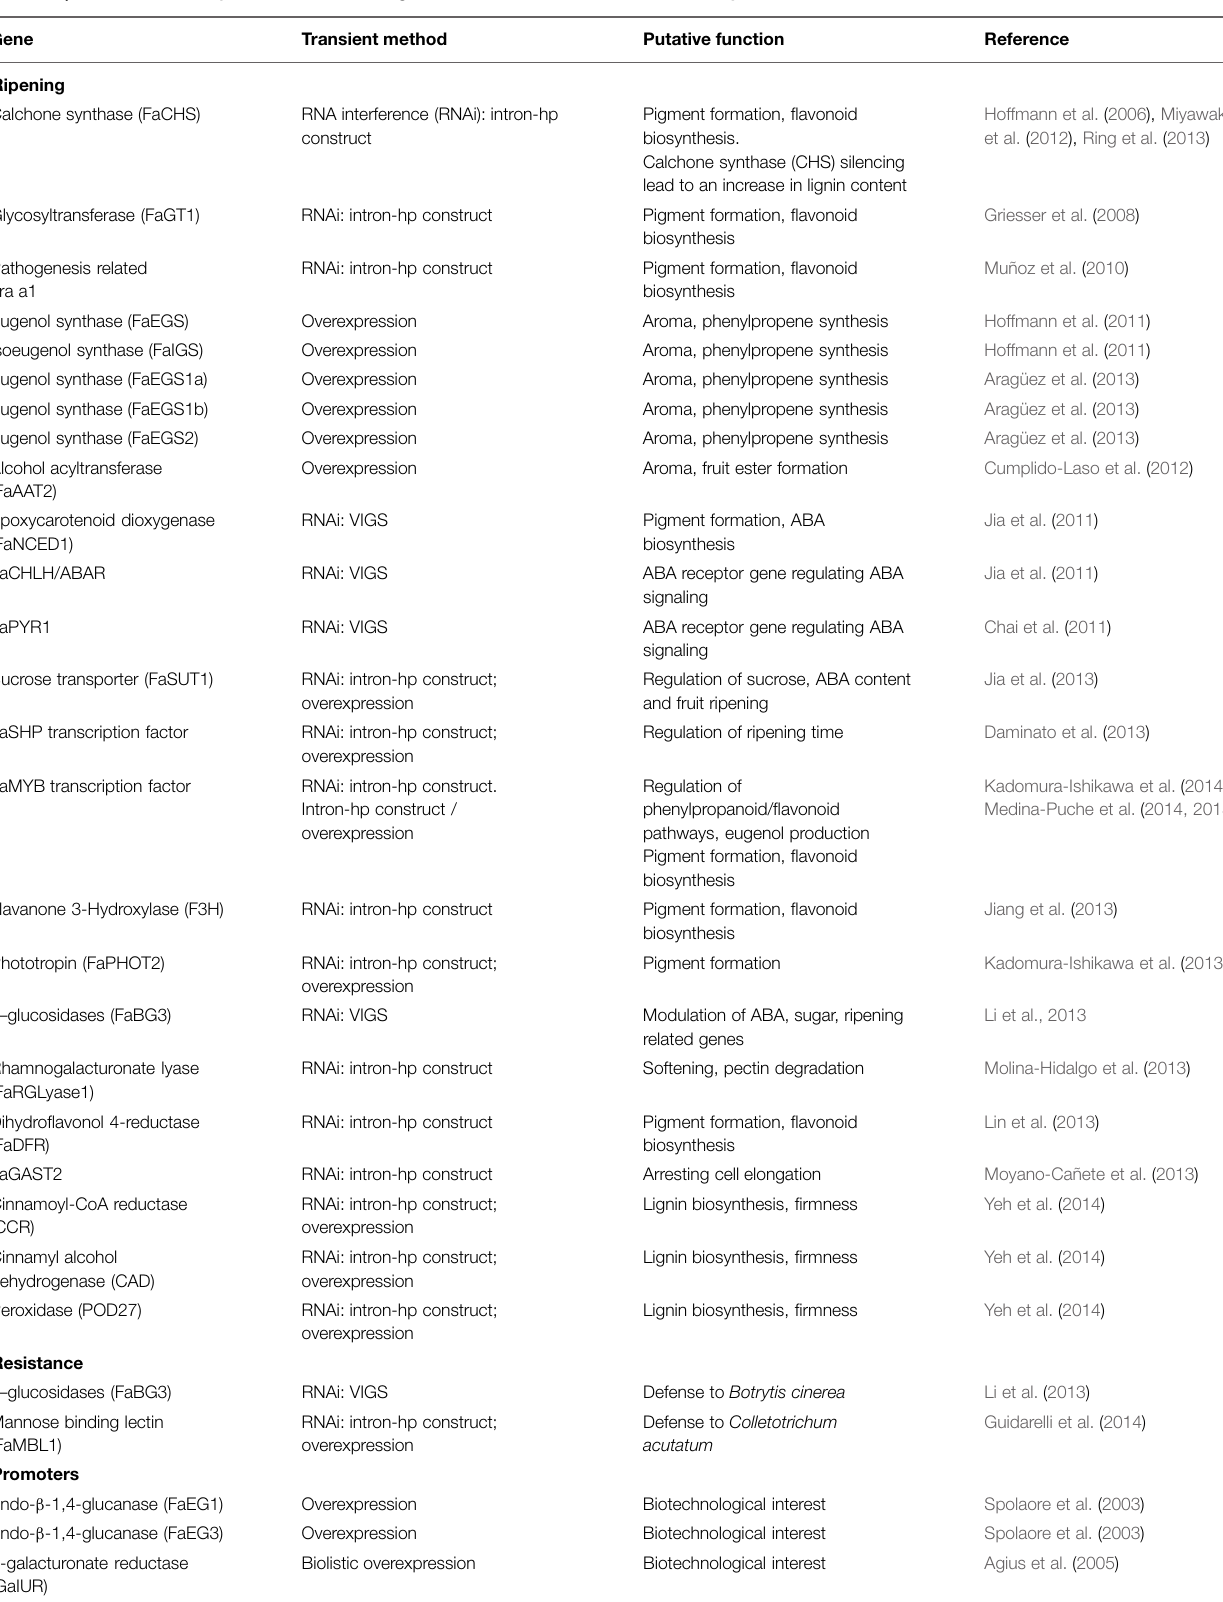
TABLE 1 | Genes functionally characterized through transient transformation in